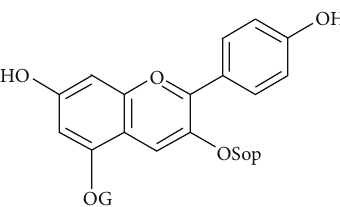
Figure 1: The structural formula of radish red